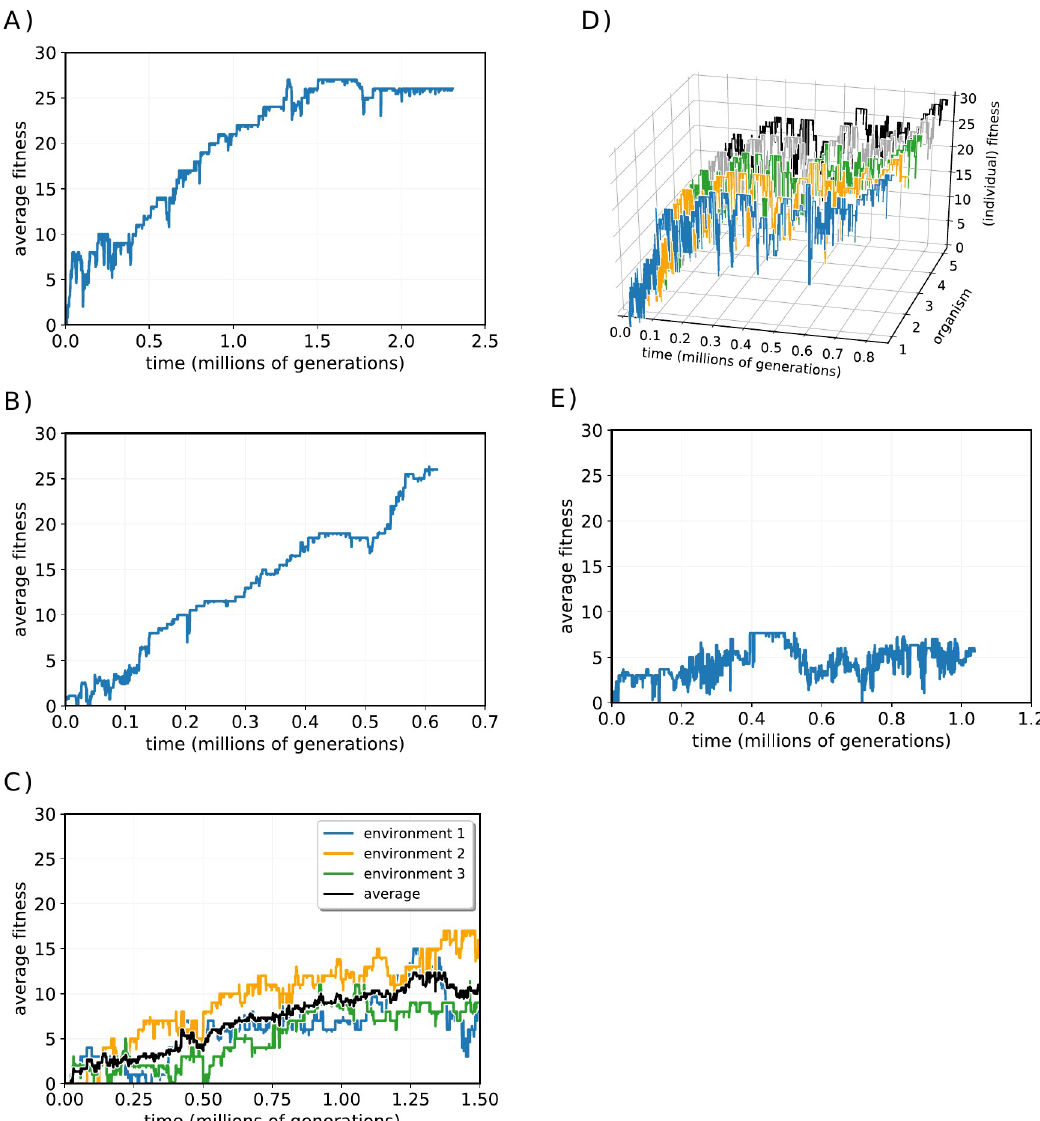
Fig 3. Examples of fitness plots for different runs of the model. For all curves: Y axis = fitness, X axis = time in units of generations. A: Average fitness of the population converges smoothly on a maximum. B. Average fitness shows a jump in adaptation at 500,000 generations. C. convergence of average fitness across three environments, showing divergent adaptation to each of the environments. D. Fitness of each of the five organisms making up the population plotted separately in a run that converges on a solution. E. Plot of fitness in a run that fails to converge on an optimum fitness.